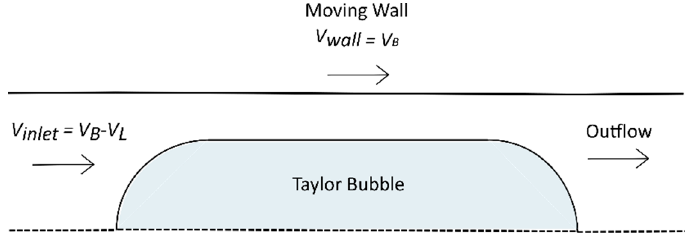
Figure 1. Domain of the simulations in a microchannel with a diameter of 100 μ m.